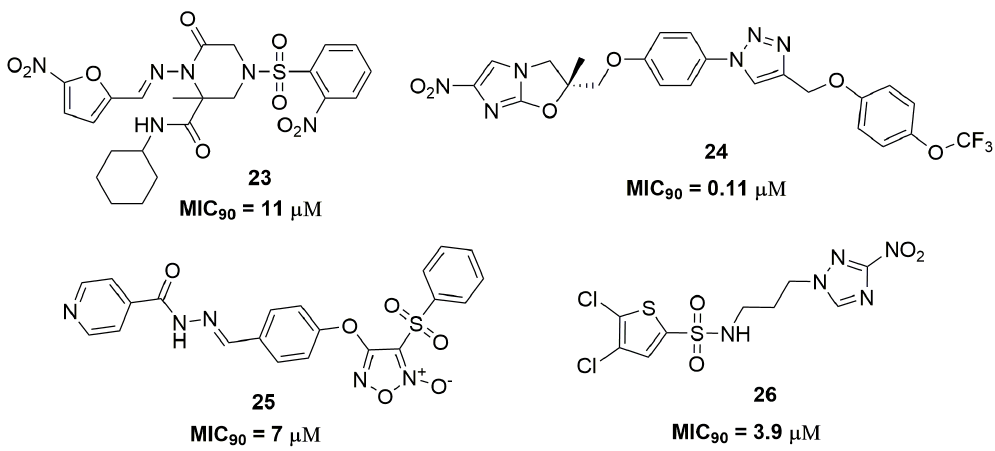
Figure 9. Compounds with antituberculosis activity that acts through the release of reactive oxygen and nitrogen species.